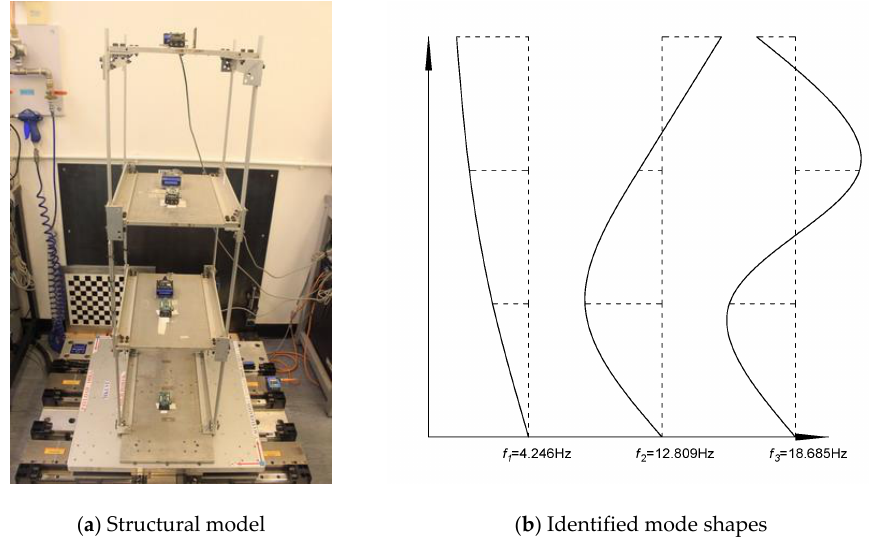
Figure 10. The tested three-storey shear-type structure model and its identified mode